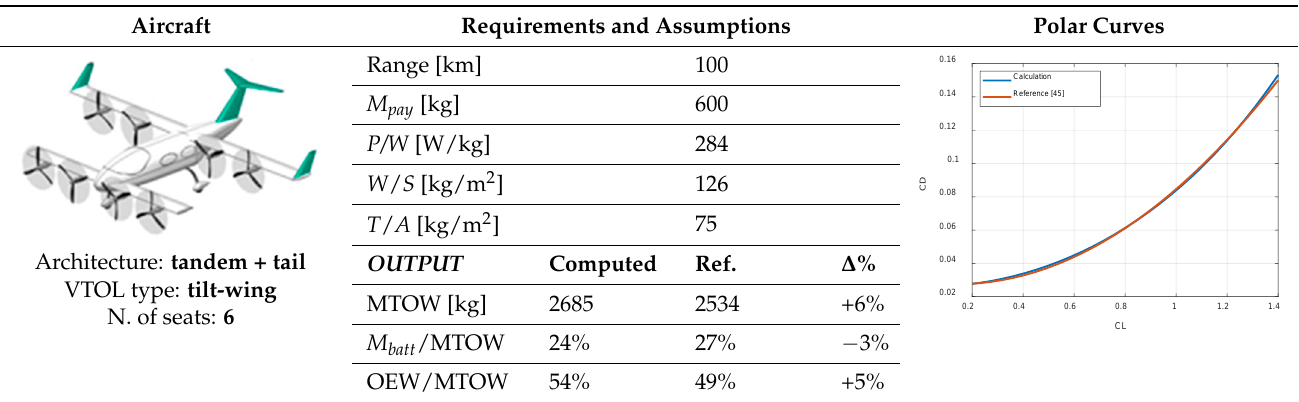
Table 7. Comparison with the six-passenger configuration of the reference paper [45].